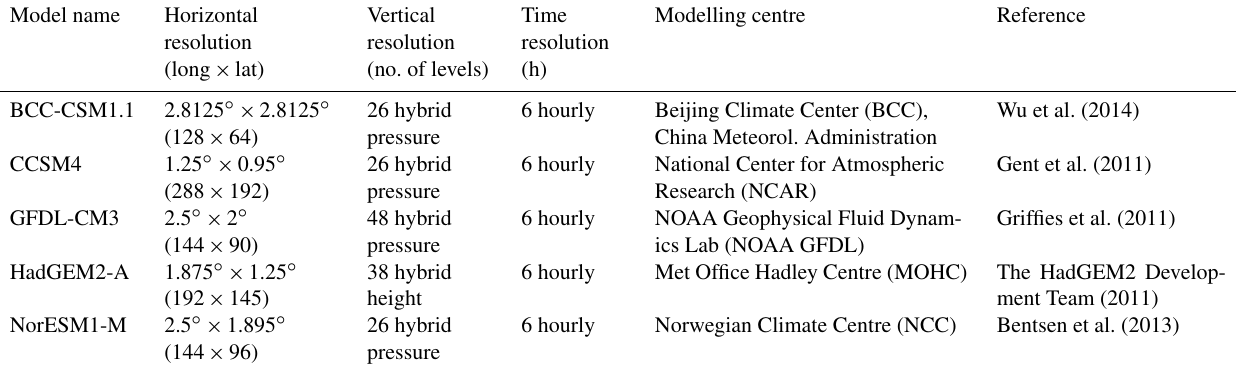
Table 1. Information on models: model name; horizontal, vertical, and time resolution; modelling centre; and references. Model